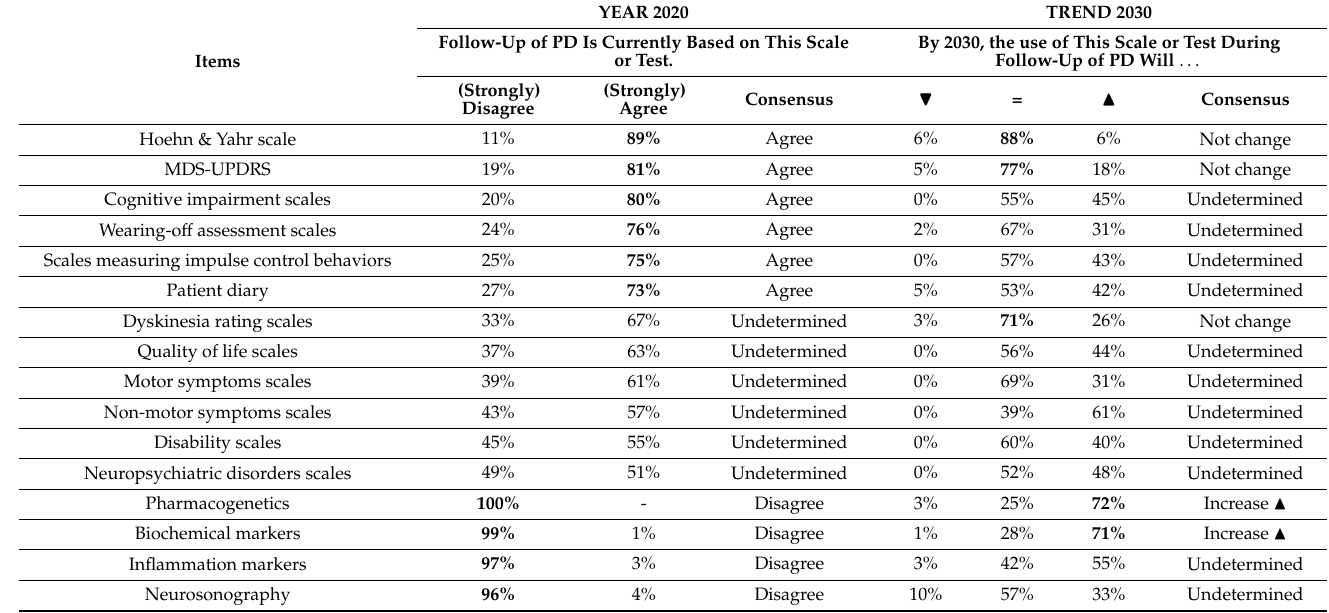
Table 3. Criteria, scales and/or tests for the follow-up of PD: present and future (percentages of respondents after both